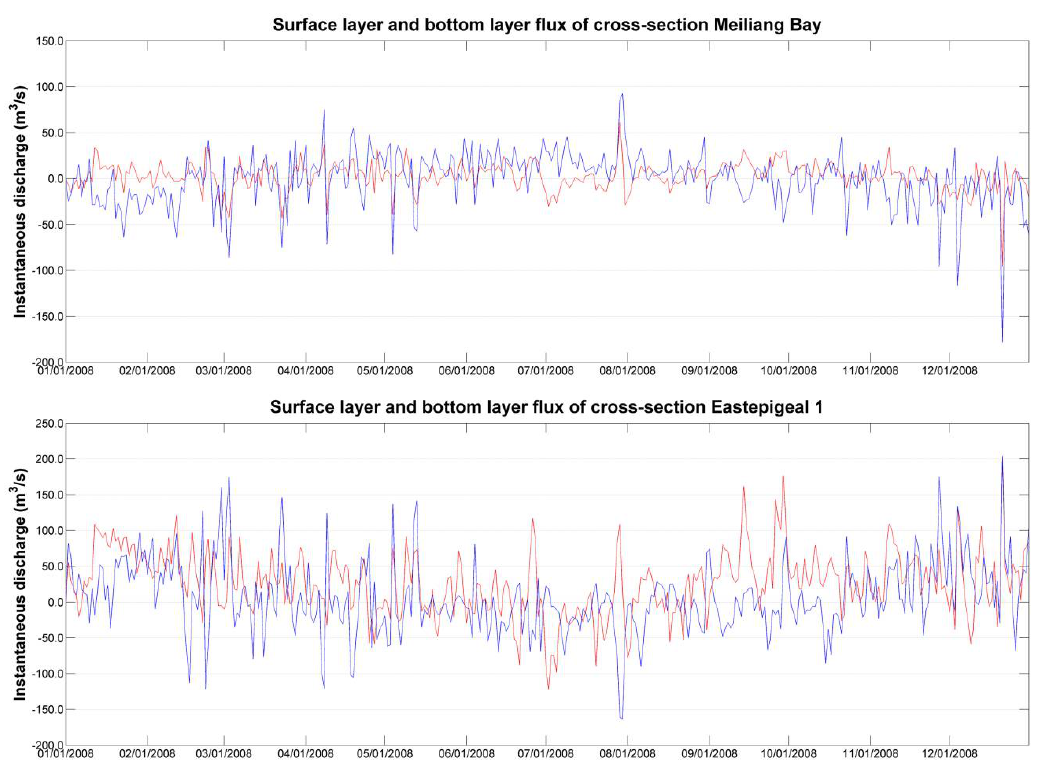
Figure 11. Time series of surface and bottom flux of reference scenario (case 1), the red line refers to bottom flux, and the blue line refers to the surface flux, and the unit in the figure is m 3 /s.